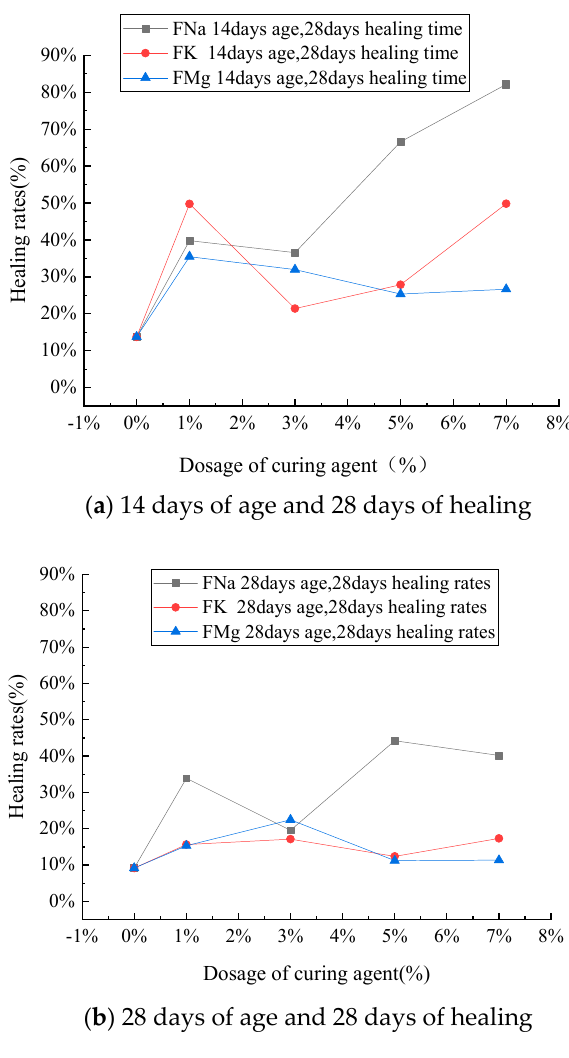
Figure 8. ( a , b ) Healing rates of specimens with three different curing agents.